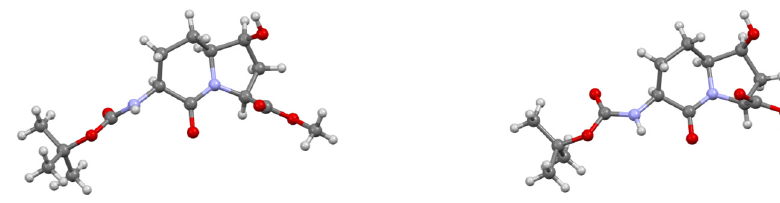
Figure 3. Depictions of conformers in the X-ray structure of (6 S ,7 S )- 9 .